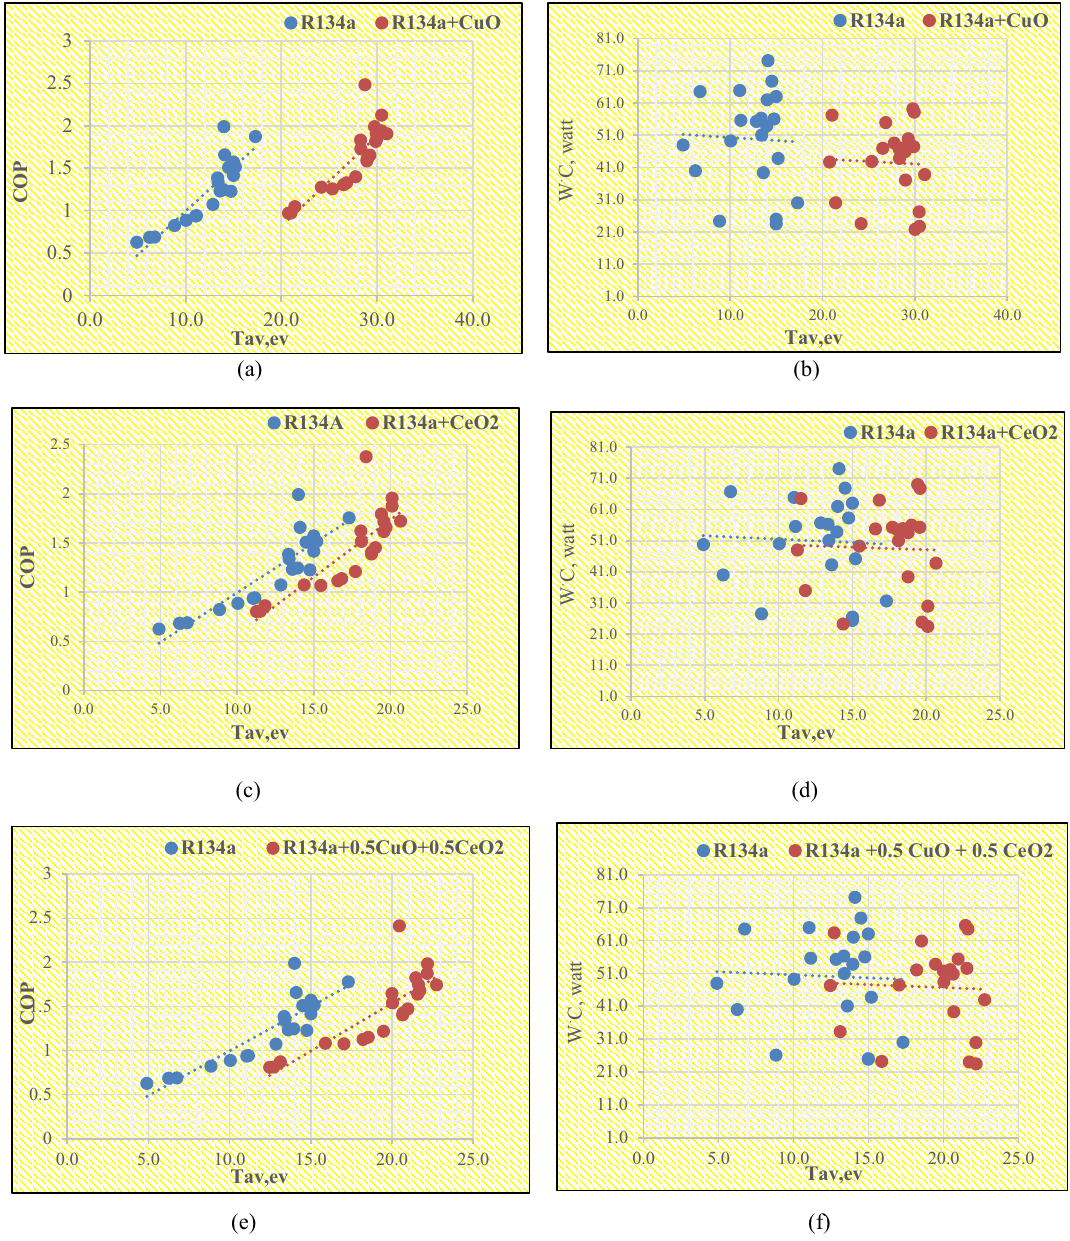
Figure 8. The effects of Tav, ev on Cop and WC at a constant mass fraction and comparison of the results of VCRS with nano and without